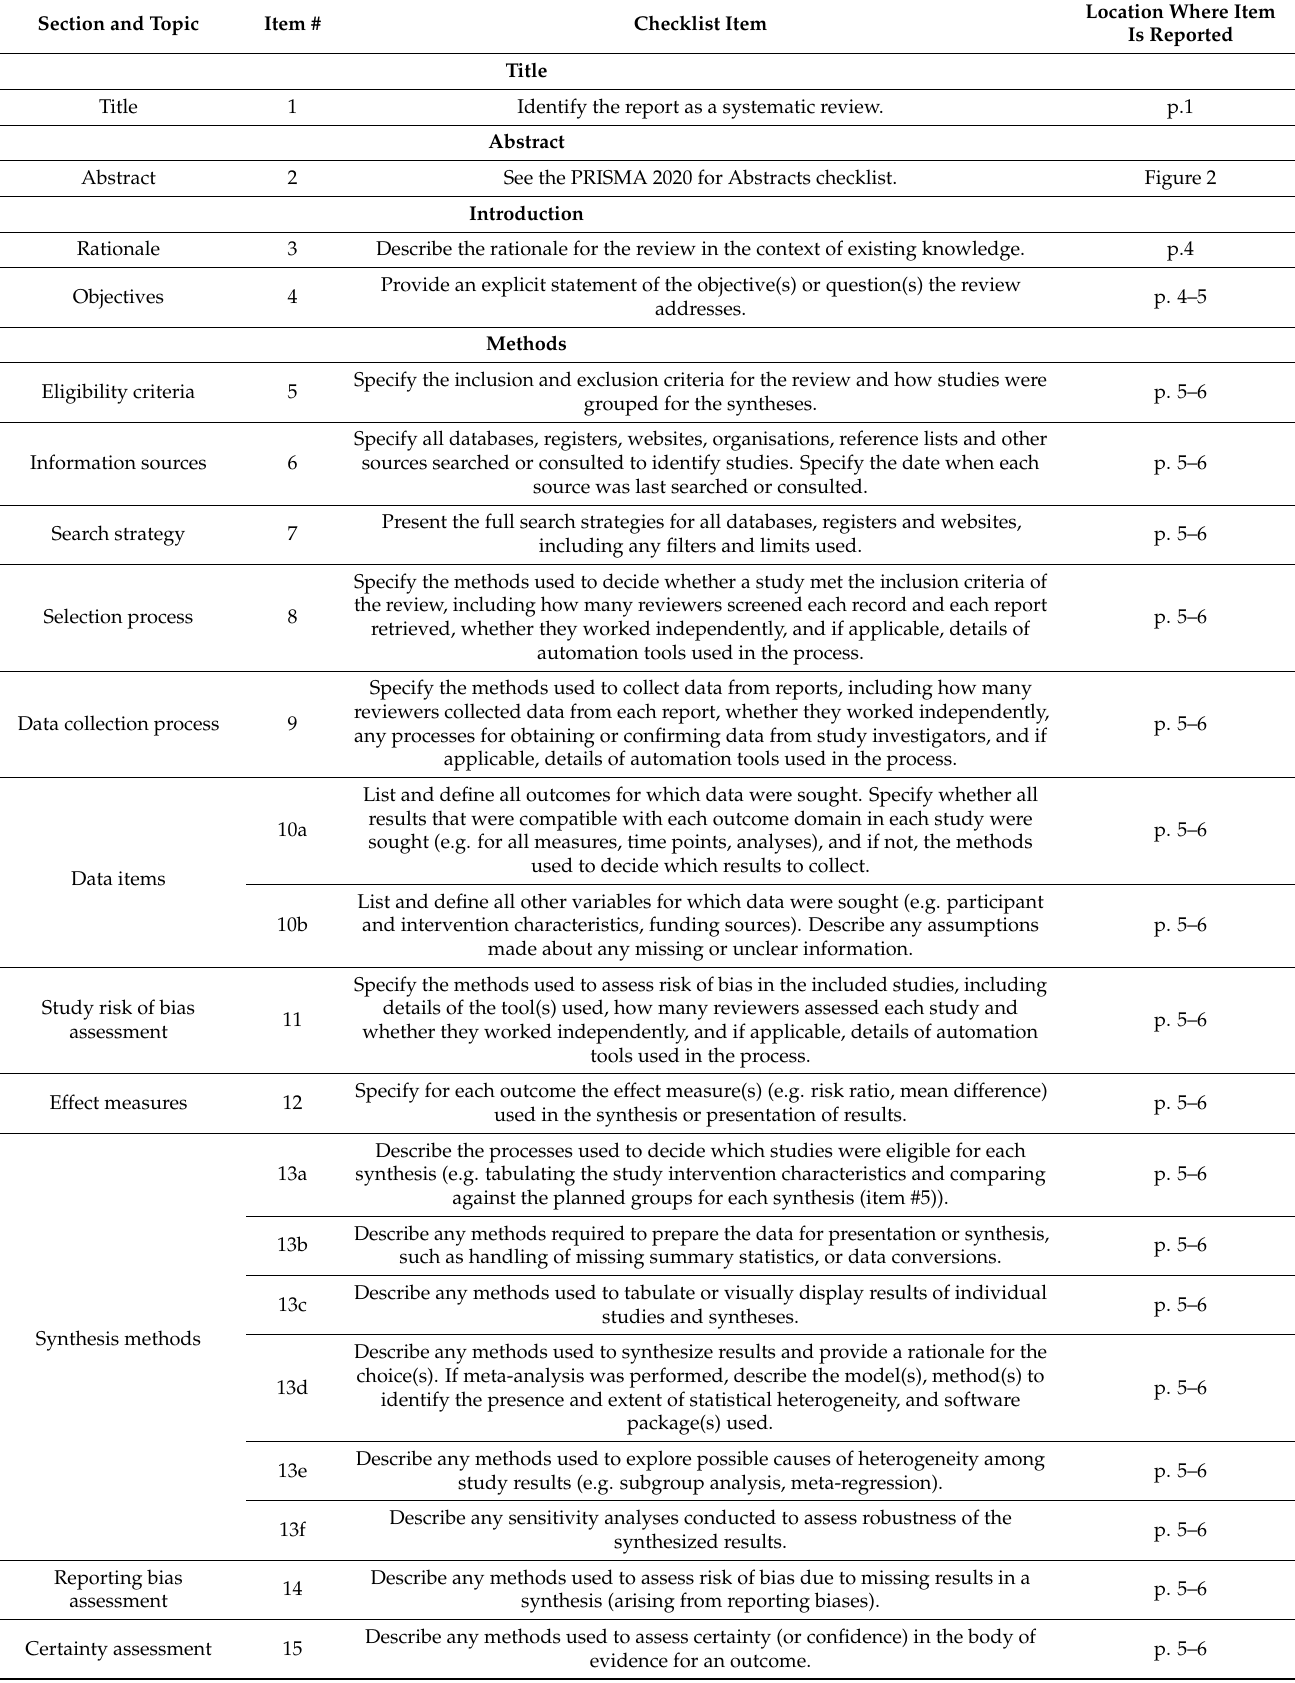
Table 2. PRISMA Checklist Manuscript Design http://www.prisma-statement.org/ (accessed on 13 June 2021)